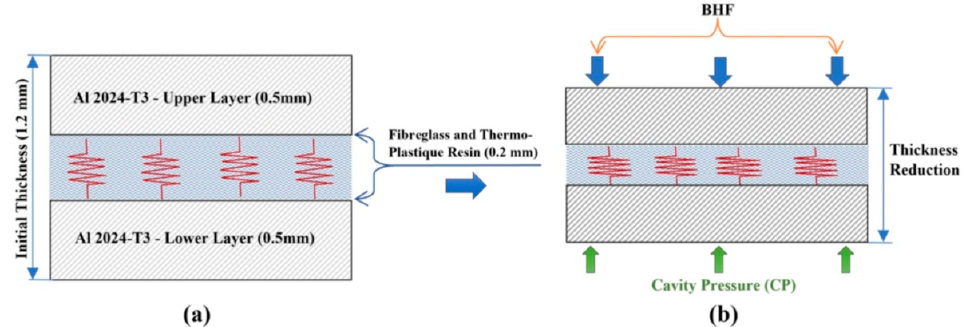
Figure 38. Effect of clamping force on the reduction in FML thickness (reprinted with permission from [384]; copyright© 2021, Springer ‐ Verlag London Ltd., part of Springer Nature).